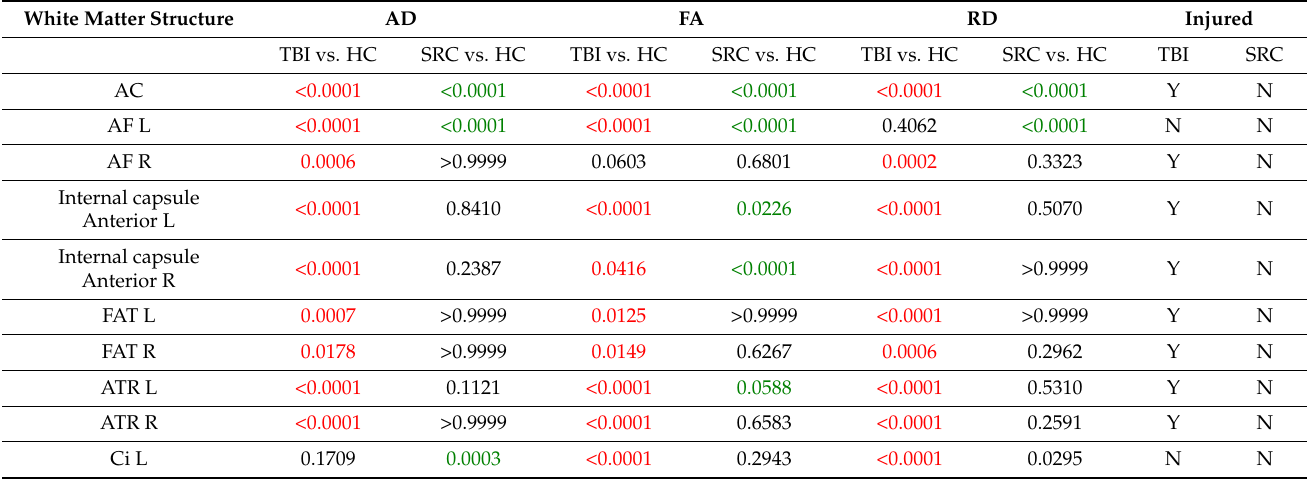
Table 2. Analysis of global white matter